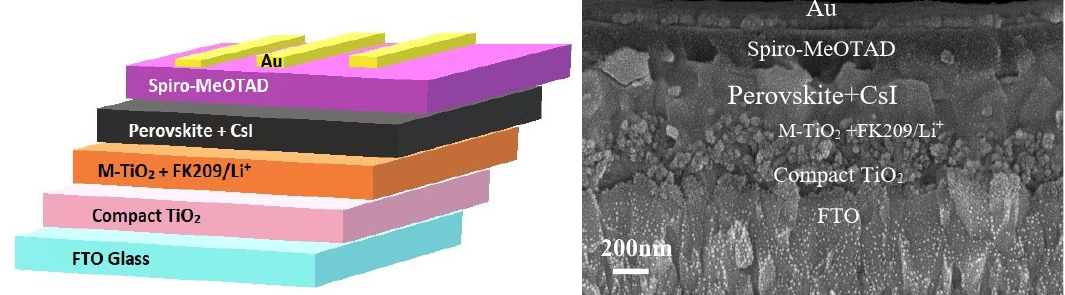
Figure 2. ( Left ) A schematic structure of the perovskite solar cell; ( right ) an SEM image of the cross-sections of the perovskite solar cell device fabricated in this study.